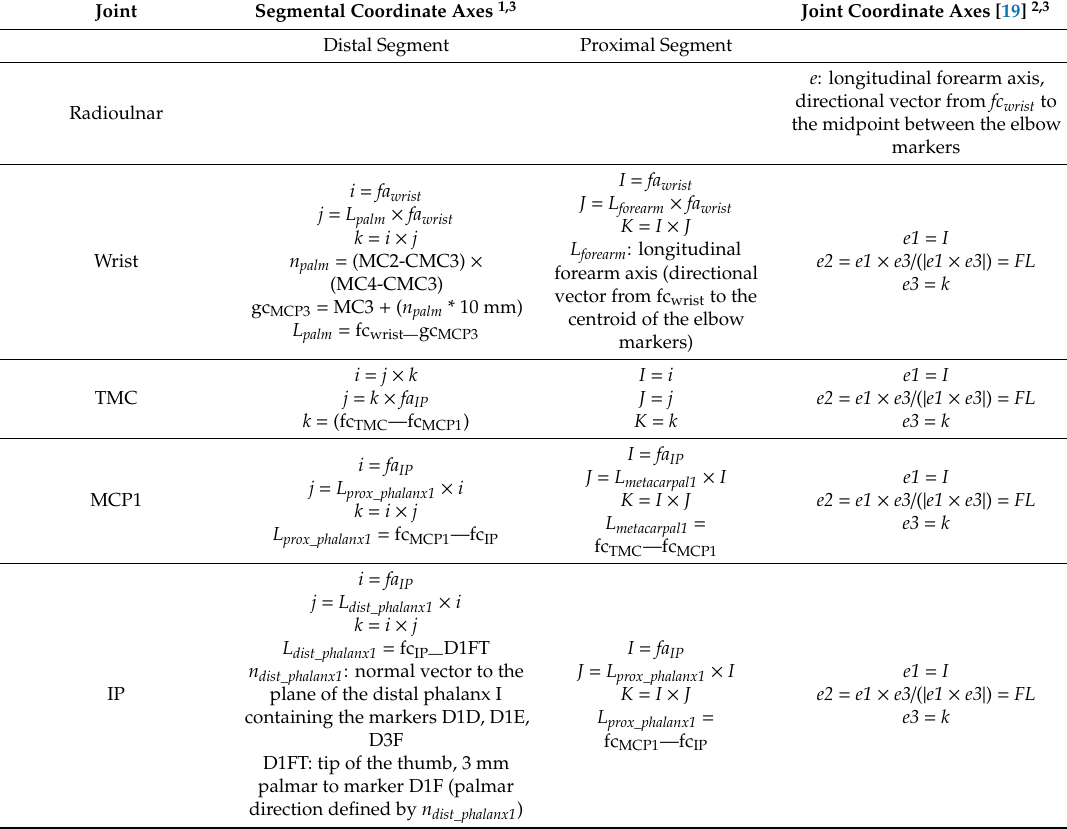
Table 3. Equations used for the segmental and joint coordinate